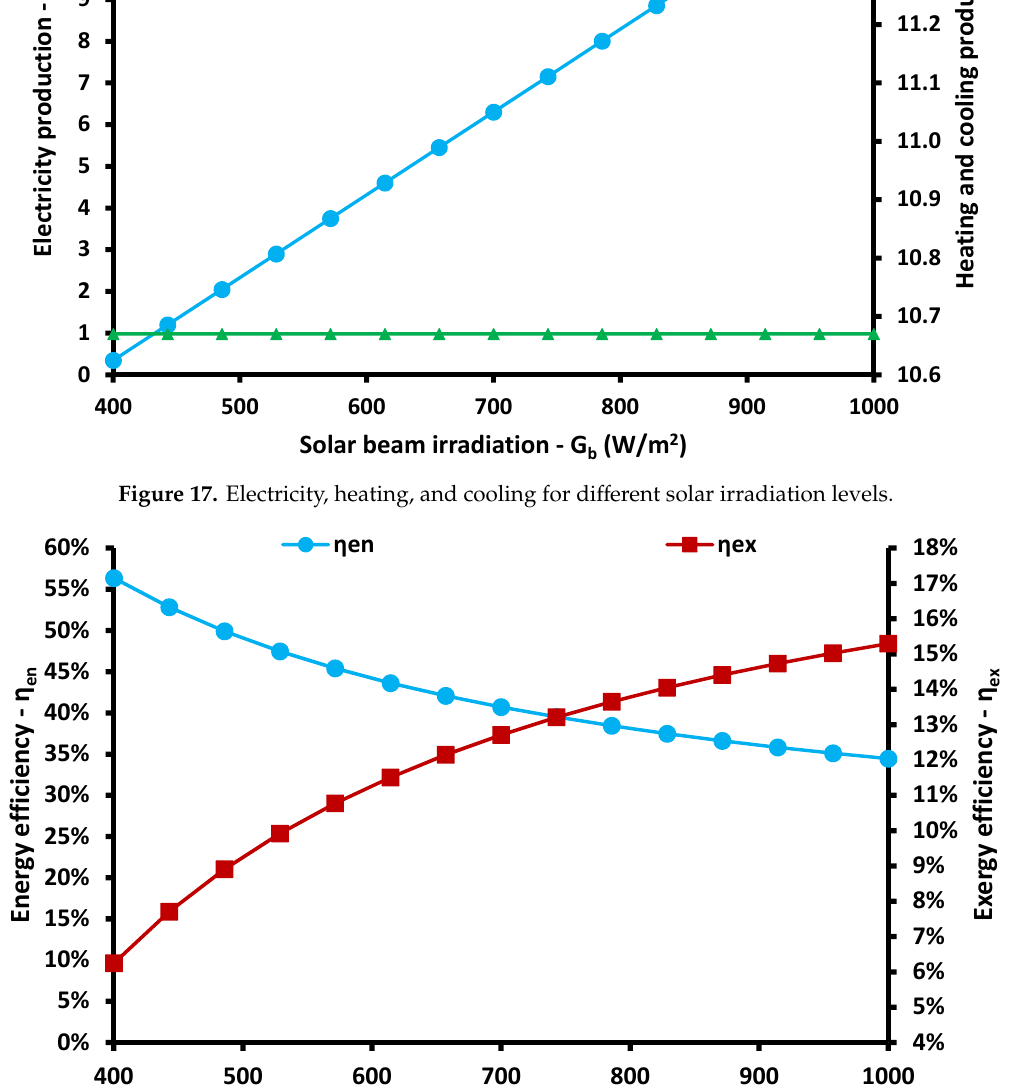
Figure 19. Simple payback period and hourly cash flow for different solar irradiation levels. Figures 20 to 22 show the results of the impact of the incident solar angle on the system performance. This angle regards the angle between the sun and the collector aperture which follows the sun with a single-axis tracking system. As a result of the existence of the tracking, the solar angle is not that high under the majority of the operating conditions. The tracking system greatly increases the optical efficiency and this is an important point that has to be taken into consideration in studies such as the present one. Figure 20 shows that electricity production decreases with the increase of the solar angle because there are higher optical losses in the PTC and reduced useful heat production. However, the heating and the cooling remain constant due to the constant heat input in the generator.